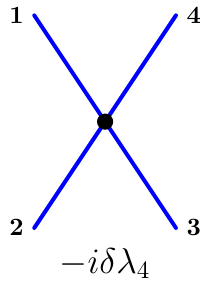
Figure 13. Diagrammatic representation of the one loop counter-term for (cid:21) 4